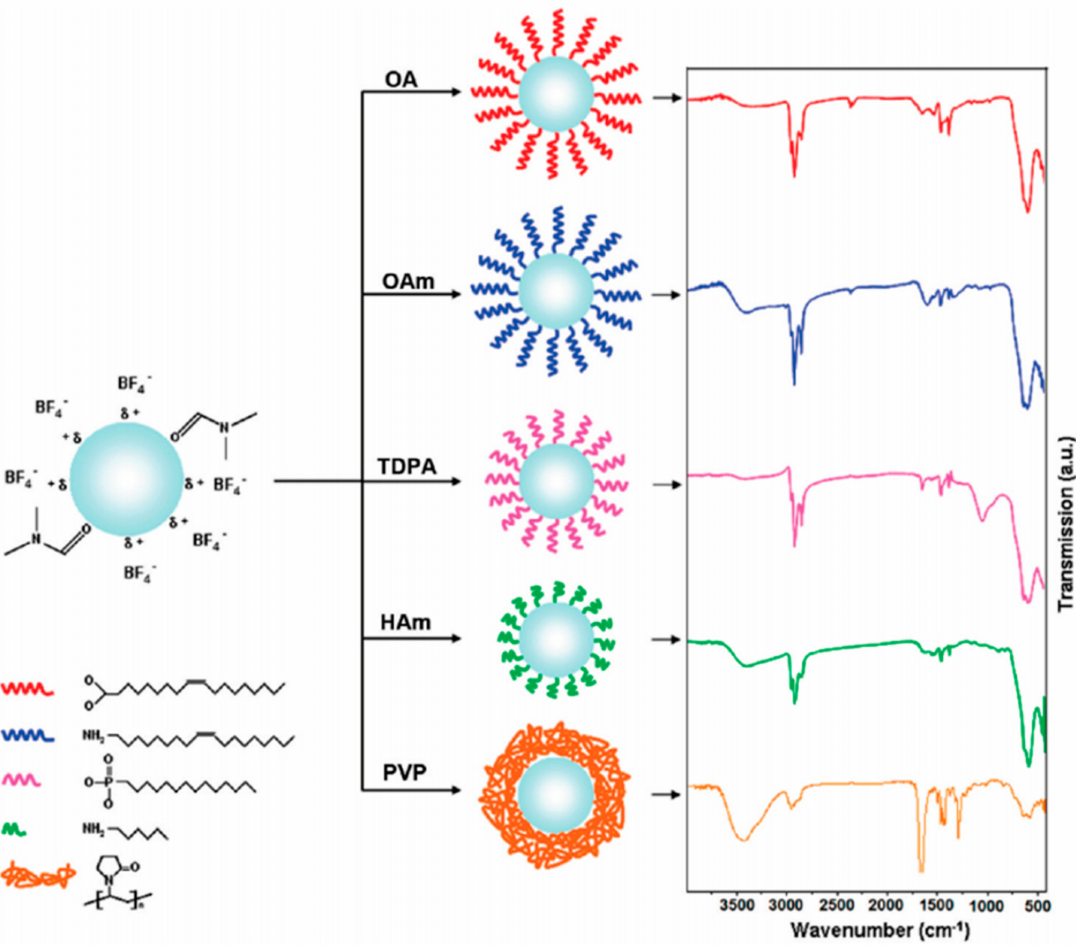
Figure 12. Schematic illustration of the secondary ligand exchange procedure and the corresponding FTIR spectra. Reprinted with permission from [77]. Copyright 2009, American Chemical